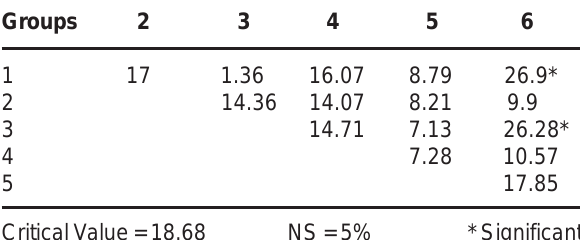
TABLE 3- Results of the statistical analysis performed on the apical group using the Miller